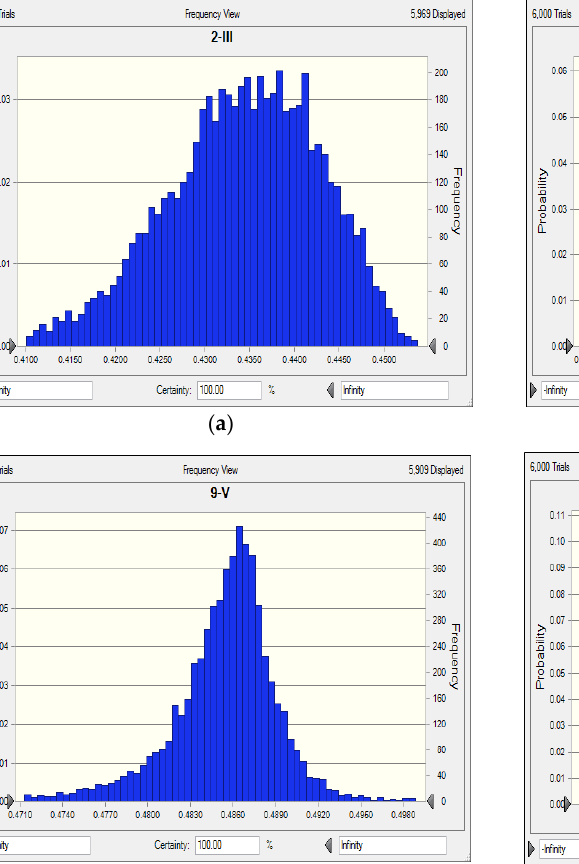
Table 7. Membership functions of three assessment methods of matter element (ME) model, fuzzy matter element model (FME) model, and cloud matter element (CME) model for Dianchi Lake (Cao Sea) (S12) and Liwan Lake (S19). Evaluated Objects